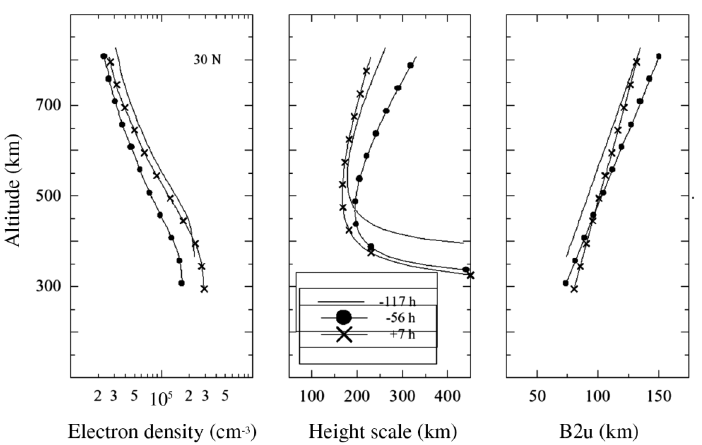
Fig. 6. Topside profiles ( left ), height scale ( middle ) and semithickness ( right ) for the period of the Irpinia earth- quake in Central Italy, November, 1980.